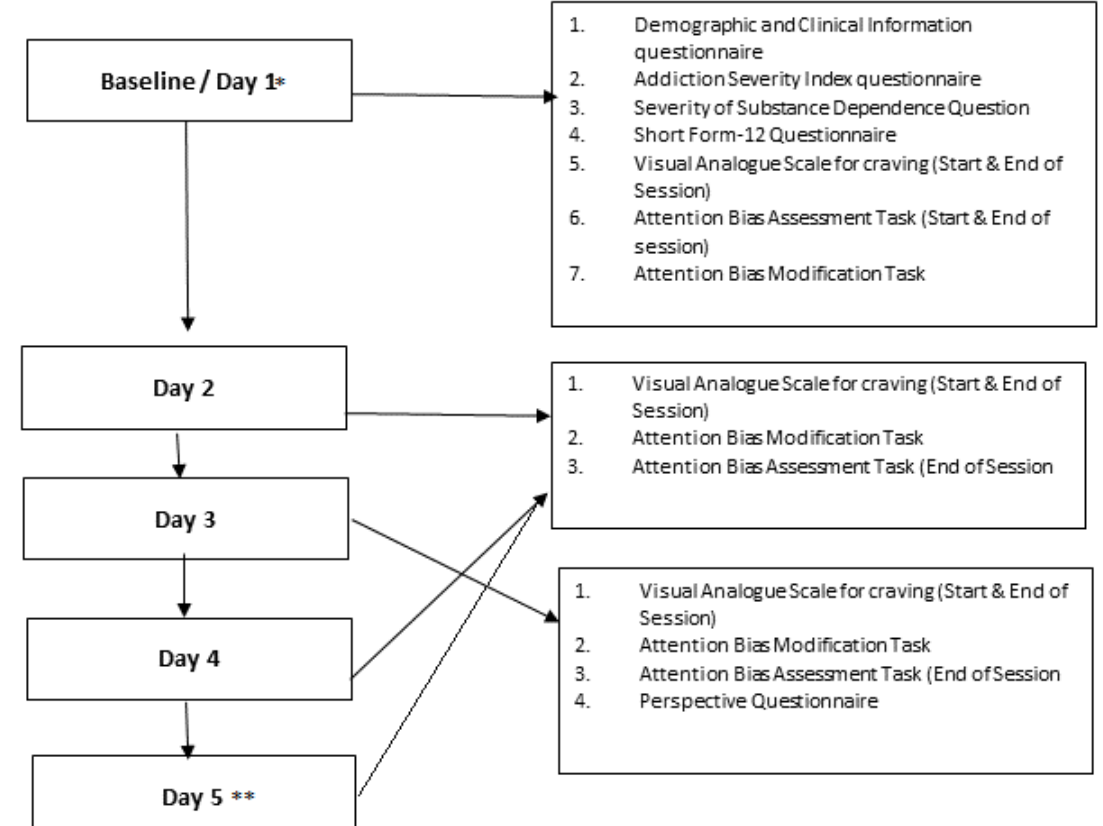
Figure 2. Overview of the outcomes measures that participants need to complete for each session. *Attention bias modification assessment task will be completed twice on the first day. The first assessment will provide information pertaining to the baseline attentional biases. The second assessment will assess for the change in attentional biases following the first intervention. **Participants will undertake a maximum of 5 sessions, taking into consideration that the study will not be conducted on